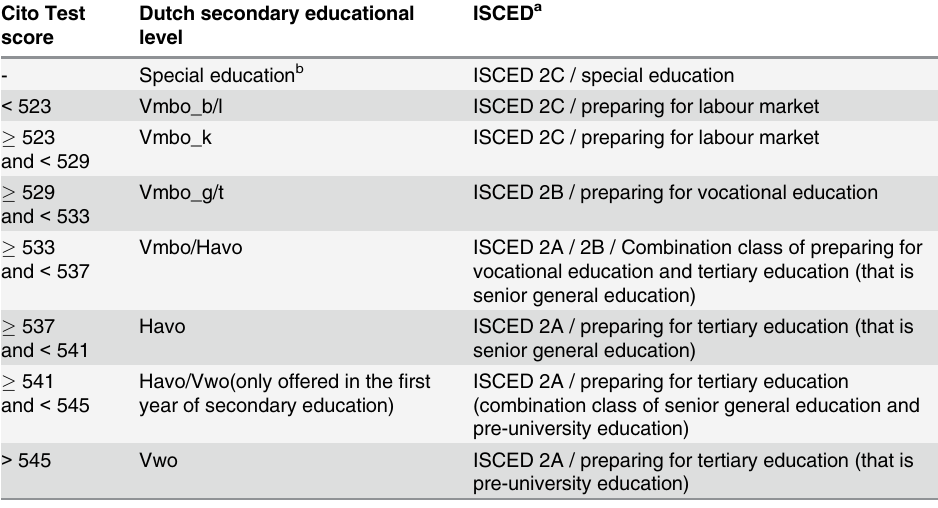
Table 1. Classification of secondary educational level according to Cito Test scores and Dutch sec- ondary educational